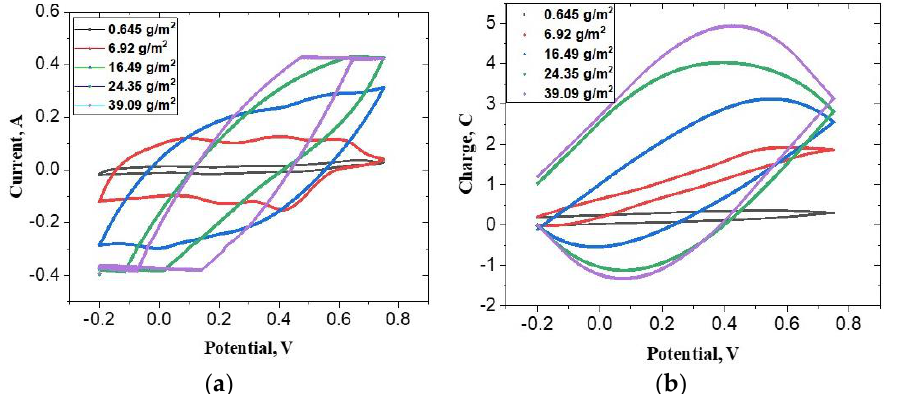
Figure 1. Cyclic voltammograms: ( a ) and cyclic coulogram plots; ( b ) of polyaniline films of different surface mass densities. Concentration of H 2 SO 4 = 0.5 M, concentration of aniline = 0.1 M and temperature = 25 °C. Scan rate = 50 mV s − 1 . All potentials are reported with respect to SCE.